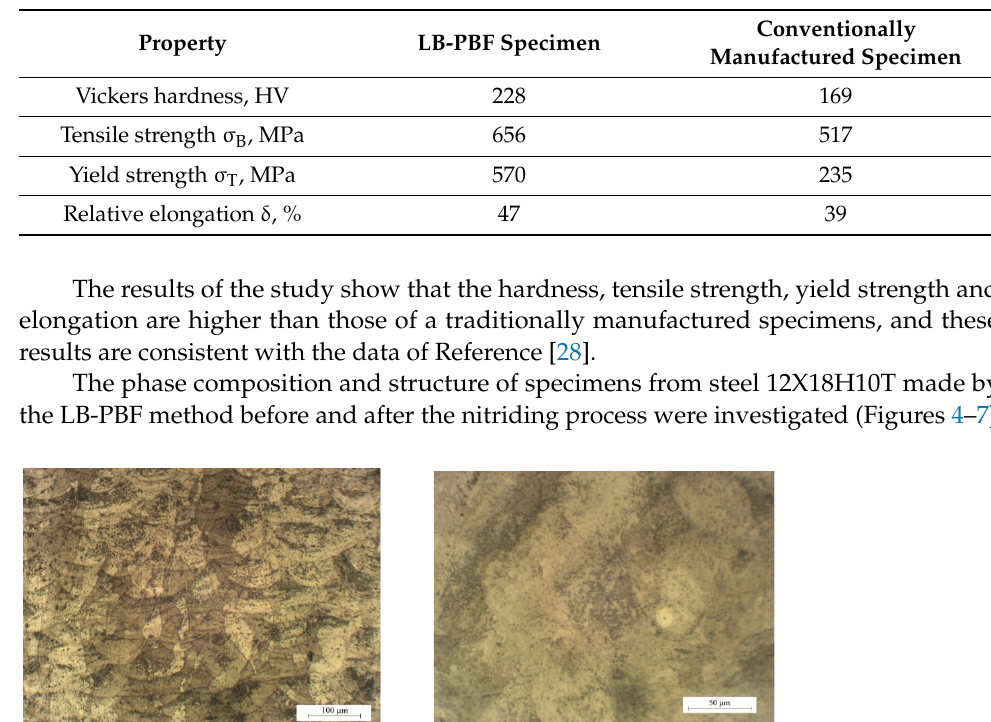
Figure 4. Microstructure of steel 12X18H10T manufactured by the LB-PBF: ( a ) cross-section perpen- dicular to the direction of laser scanning, ×200; ( b ) longitudinal cross-section parallel to the direction of laser scanning, ×500.